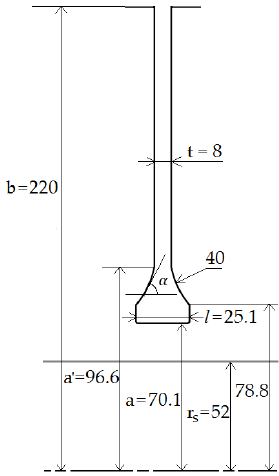
Figure 6. Simplified diagram of instrumented disc of Sussex rig (Dimensions in mm) [4].